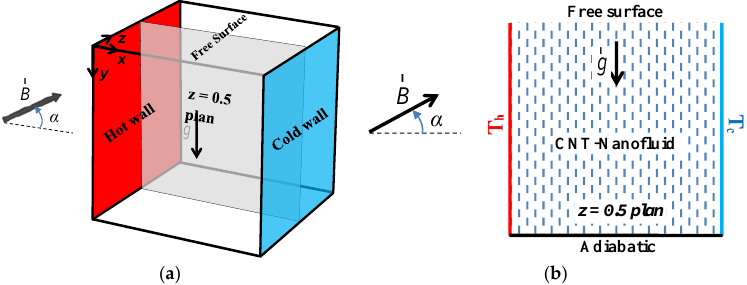
Figure 1. ( a ): Considered configuration with coordinates and ( b ) the central plan ( z =